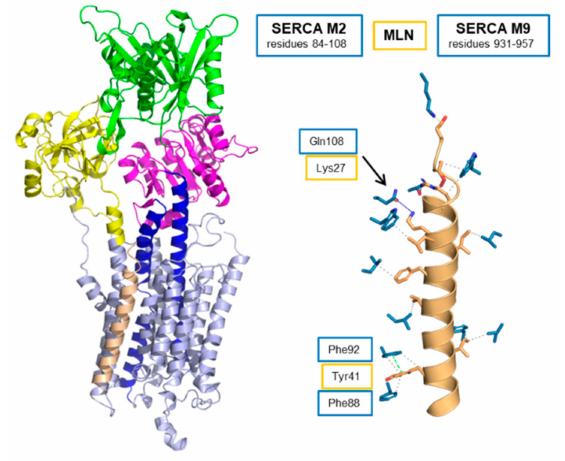
Figure 6. Molecular model of the SERCA-MLN complex. MLN is colored tan. SERCA is colored light blue with the actuator domain in yellow, the phosphorylation domain in magenta, the nucleotide- binding domain in green, and transmembrane segments M4 and M5 in blue. Also shown are Table 2. and M9 are indicated. Interactions involving Lys 27 of MLN and Gln 108 of SERCA, and Tyr 41 of MLN and Phe 88 and Phe 92 of SERCA are shown. For the full list of interactions, refer to Table S4. 6. Endoregulin (ELN) and Another-Regulin (ALN)—Non-Muscle Cells Finally